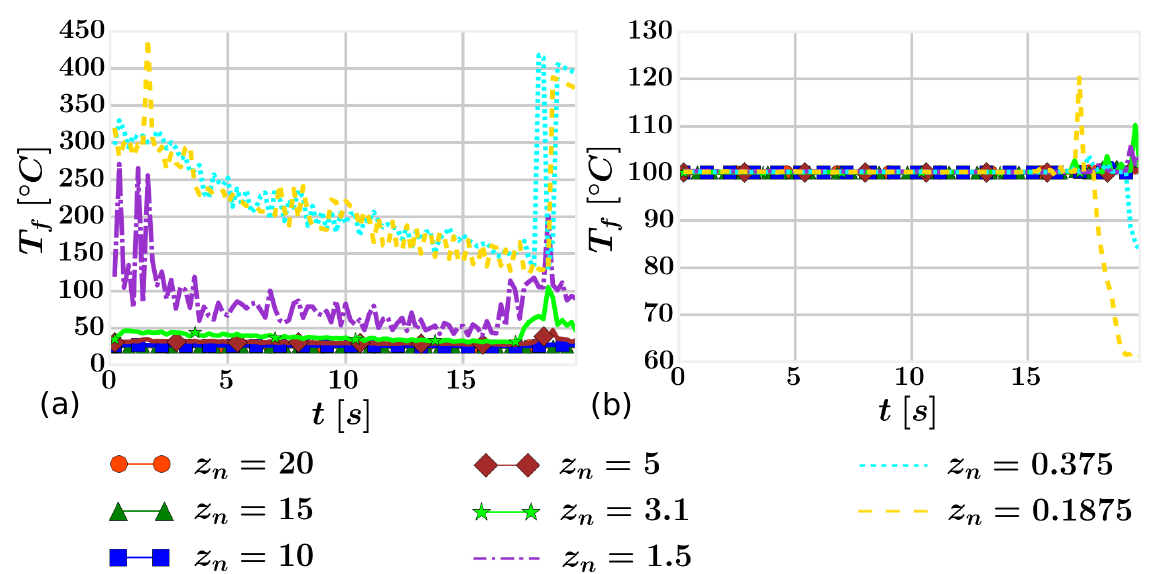
Figure 11. Maximum of liquid–vapour interfacial temperature according to Equation (5) from boundary cells centres using various fluid meshes. ( a ) IPC is not activated; ( b ) IPC is